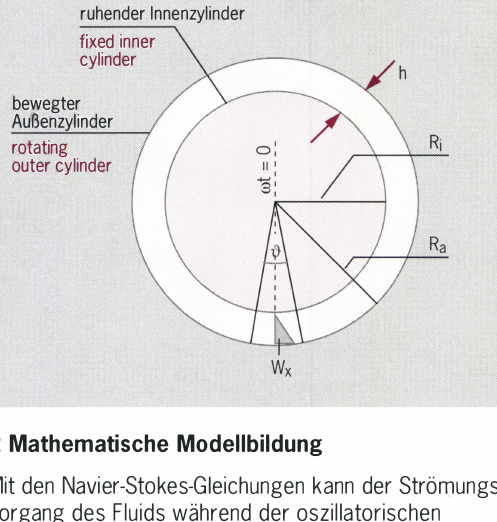
Fig. lb: The two-plate model for modeling flow between coaxial cylinders. The maximal deflection is s and the phase angle is